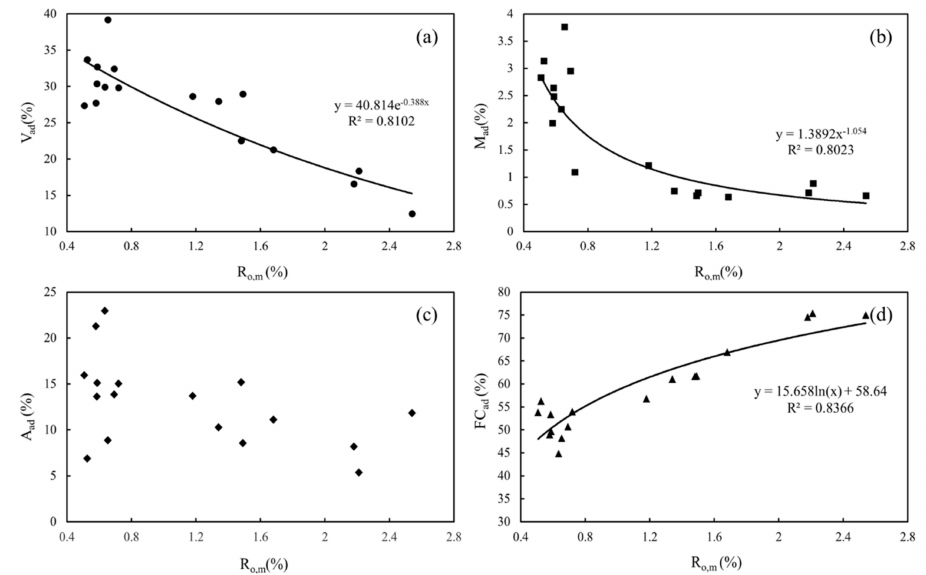
Figure 3. Relationship between the proximate analysis and di ff erent rank coals: ( a ) Volatile content (V ad , %) vs. R o,m (%); ( b ) Moisture content (M ad , %) vs. R o,m (%); ( c ) Ash yield (A ad , %) vs. R o,m (%); ( d ).Fixed carbon (FC ad , %) vs. R o,m